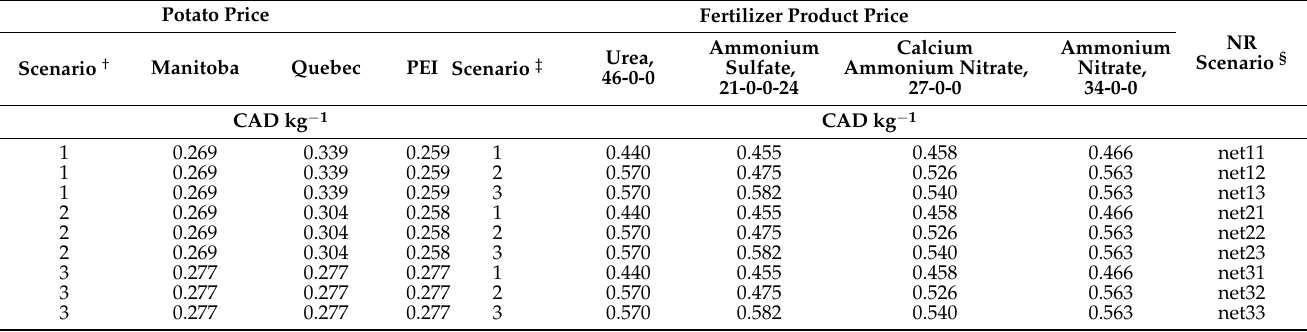
Table 5. Potato and fertilizer price scenarios for NR calculation in Manitoba, Quebec, and PEI. Potato Price Fertilizer Product